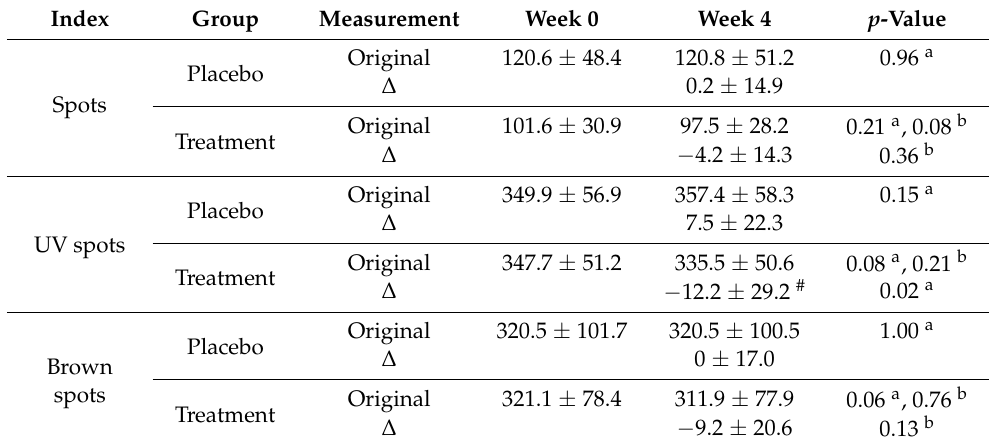
Table 3. Measurement of skin pigmentation in the subjects (mean value ± SD).